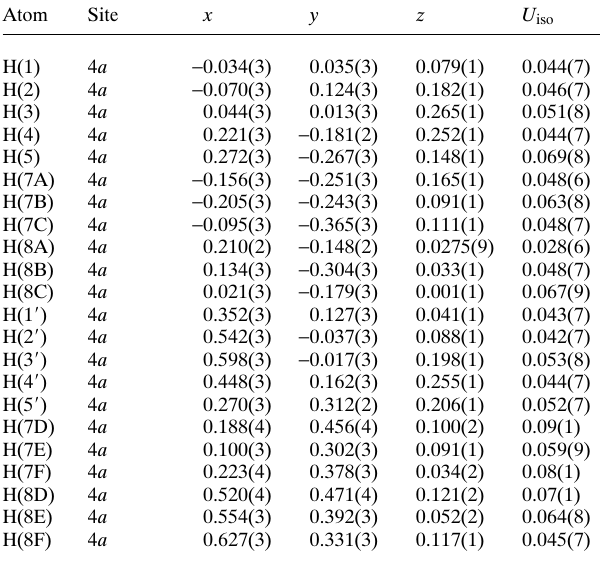
Table 2. Atomic coordinates and displacement parameters (in Å 2 )